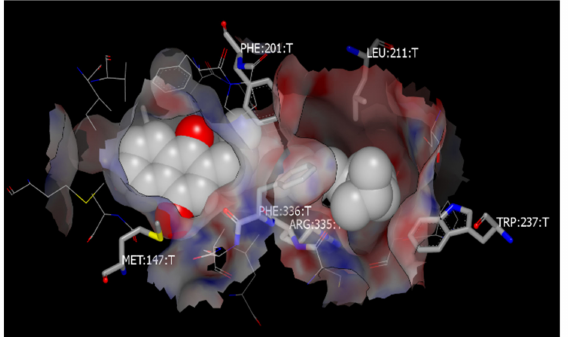
Figure 6. A selected low energy docking pose of vitamin K (White) with SR-B1, where numerous lipophilic residues are present to interact with vitamin K, similarly to the native ligand